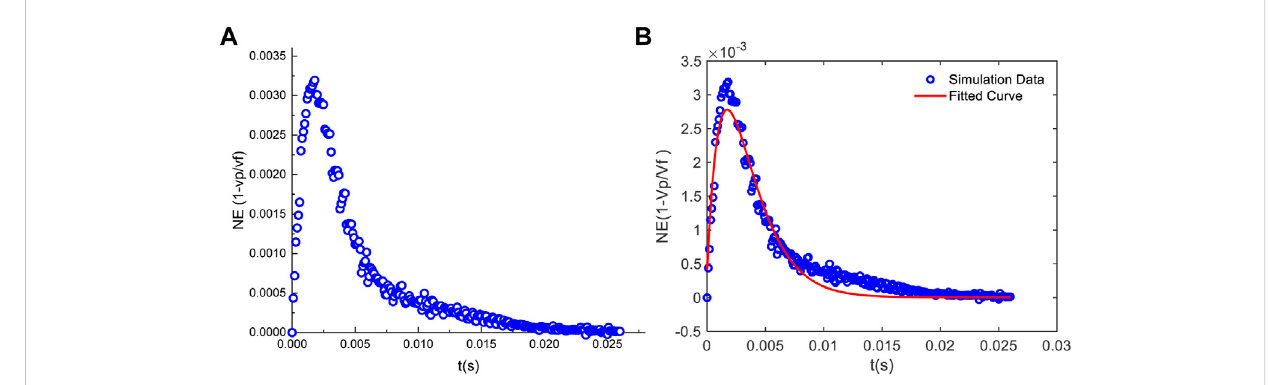
FIGURE 3 (A) NE parameter as a function of time solved using COMSOL, and (B) curve fi tting for the NE effect of a single particle using